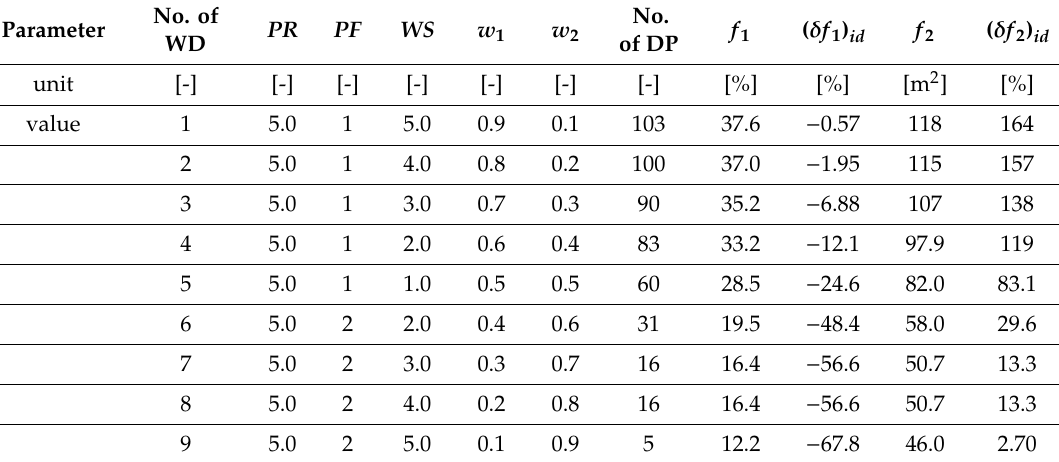
Table 2. Results of decision-making